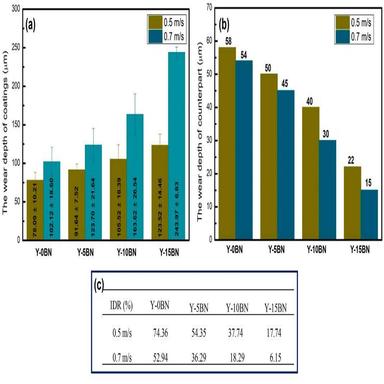
Wear depth of coatings (a), counterparts (b), and the IDR values (c).